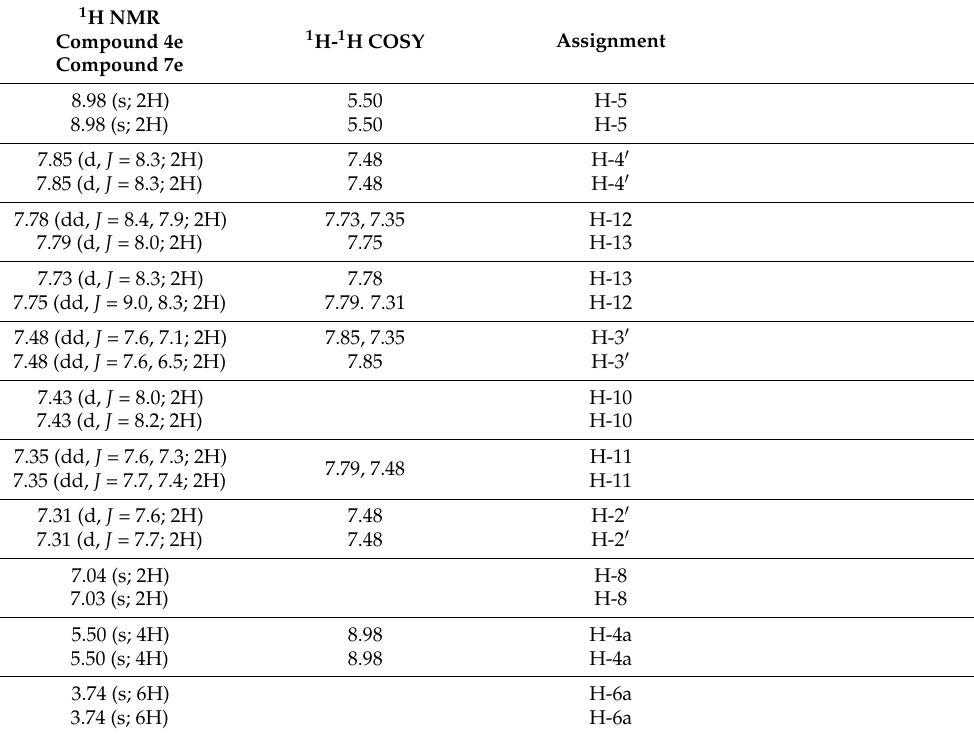
Figure 6. The similarity between structures of compounds 4e and 7e . Table 1. Spectrum data for compounds 4e and 7e